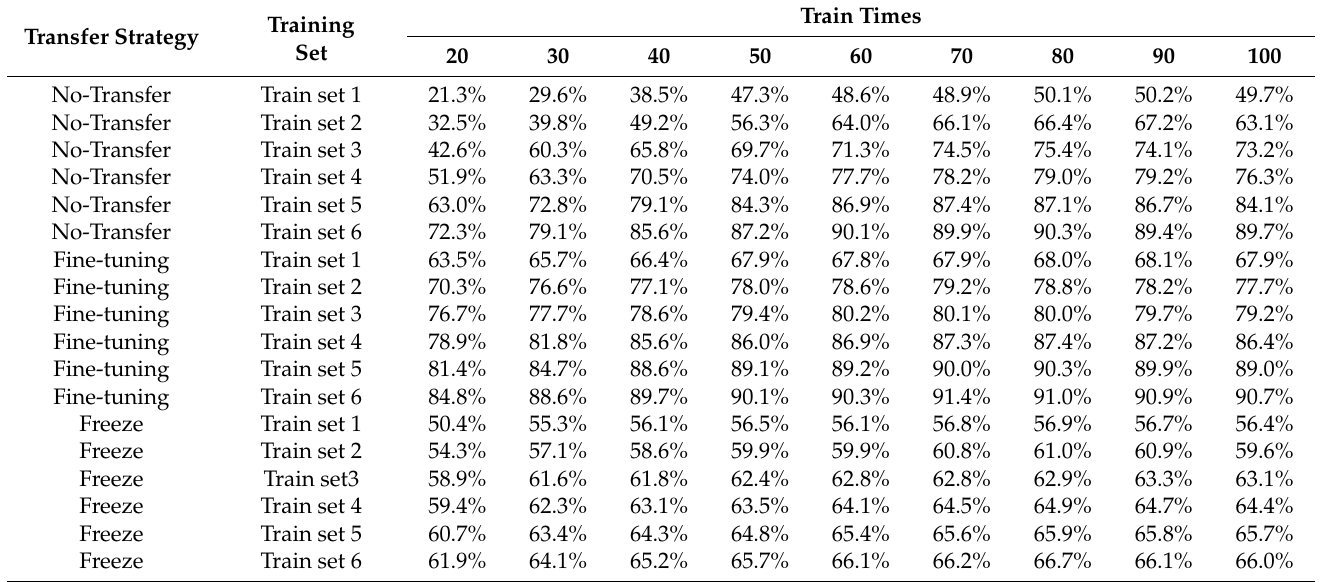
Table 3. Effect comparison of the transfer learning